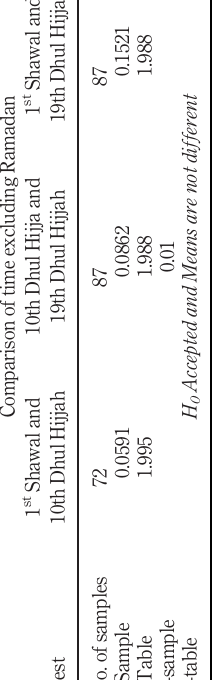
Table VI. Statistical analysis of time of busiest period from tomb to Al-Baqi ’